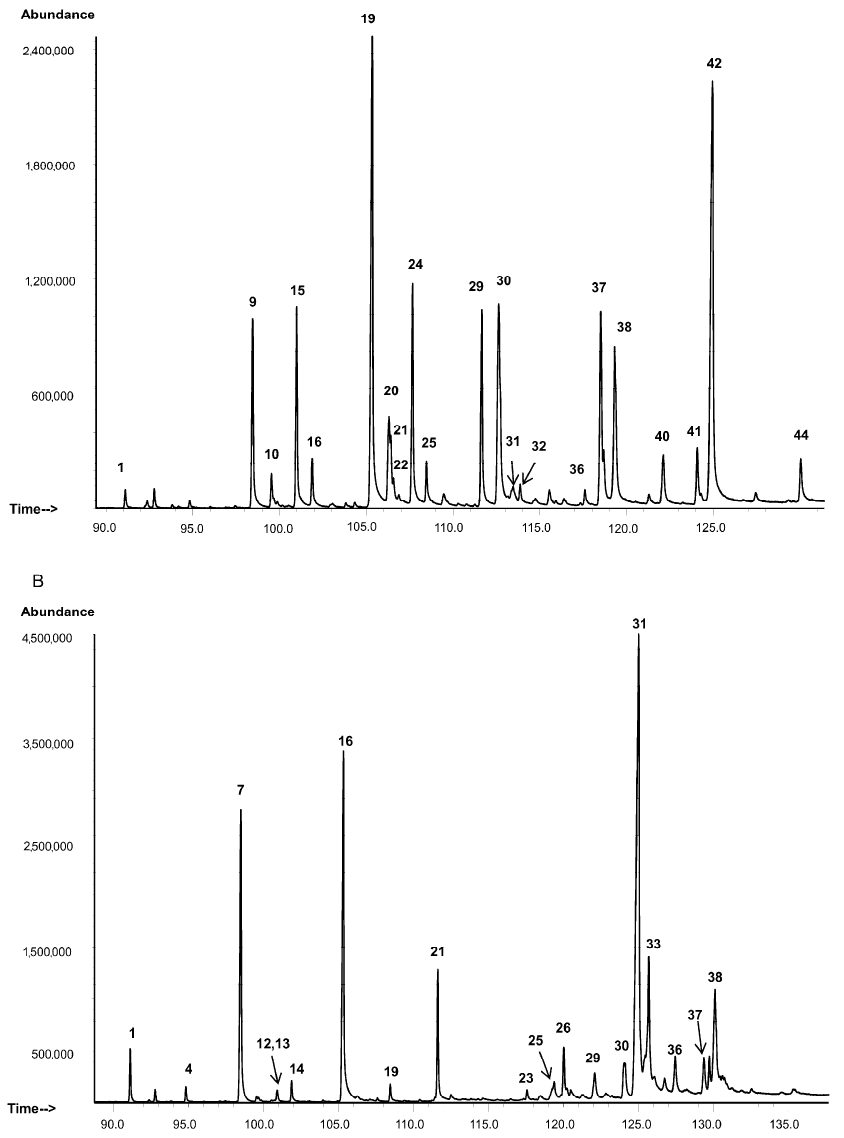
Figure 1. The chromatogram of the hydrocarbon profile of ( A ) L. migratoria and ( B ) C. italicus . Peak numbers correspond to Tables S2 and S3. Only peaks subjected to quantification are presented (area > 0.5%). Arrows indicate peaks belonging to certain numbers. Minor peaks are given in Figures S4 and S5.